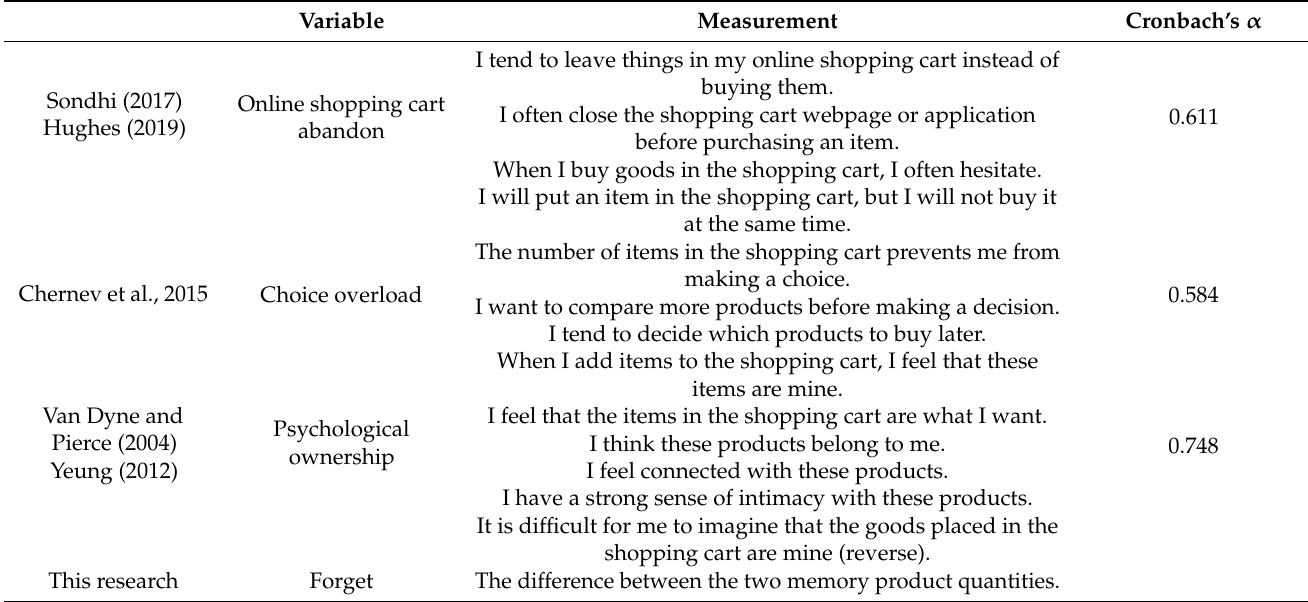
Table 4. Variable measurement